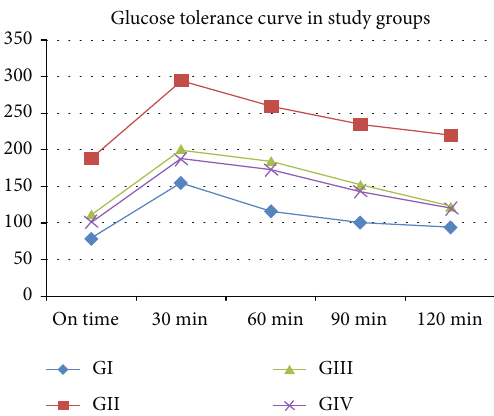
Figure 3: Glucose tolerance curve in the study groups. GI: control group; GII: diabetic group; GIII: diabetic group treated with stem cells; GIV: diabetic group treated with stem cells preconditioned with orexin